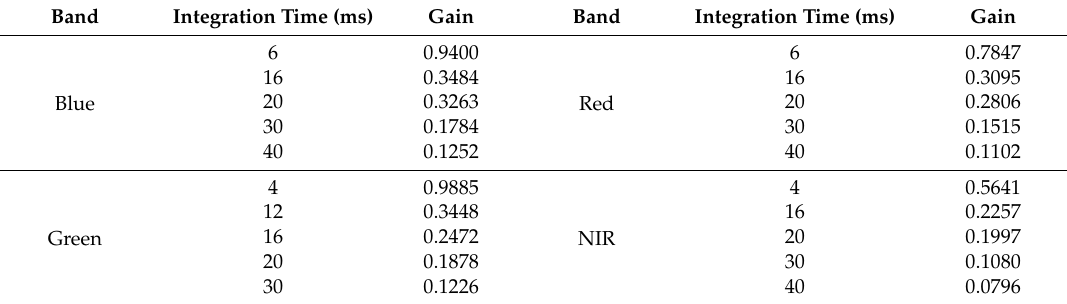
Table 6. Vicarious calibration coefficients in multispectral bands of the